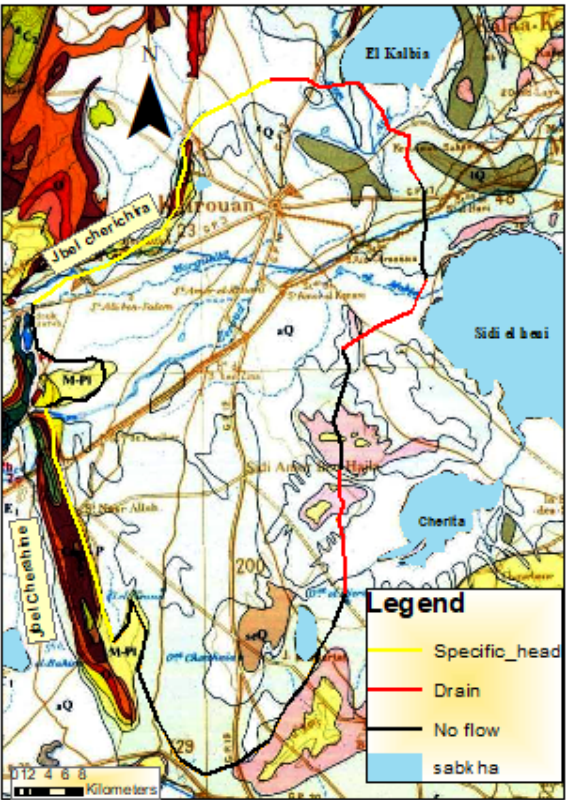
Figure 4. Boundary conditions of Mio-Plio-Quaternary aquifer (Kairouan plain).